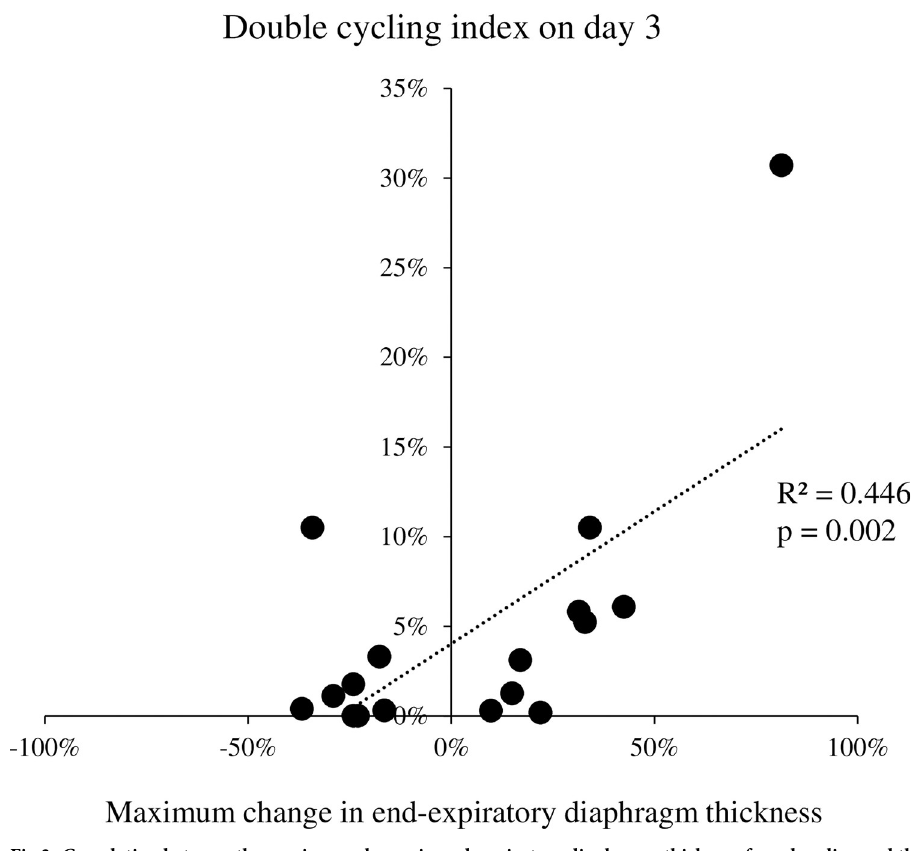
Fig 3. Correlation between the maximum change in end-expiratory diaphragm thickness from baseline and the double cycling index on day 3.